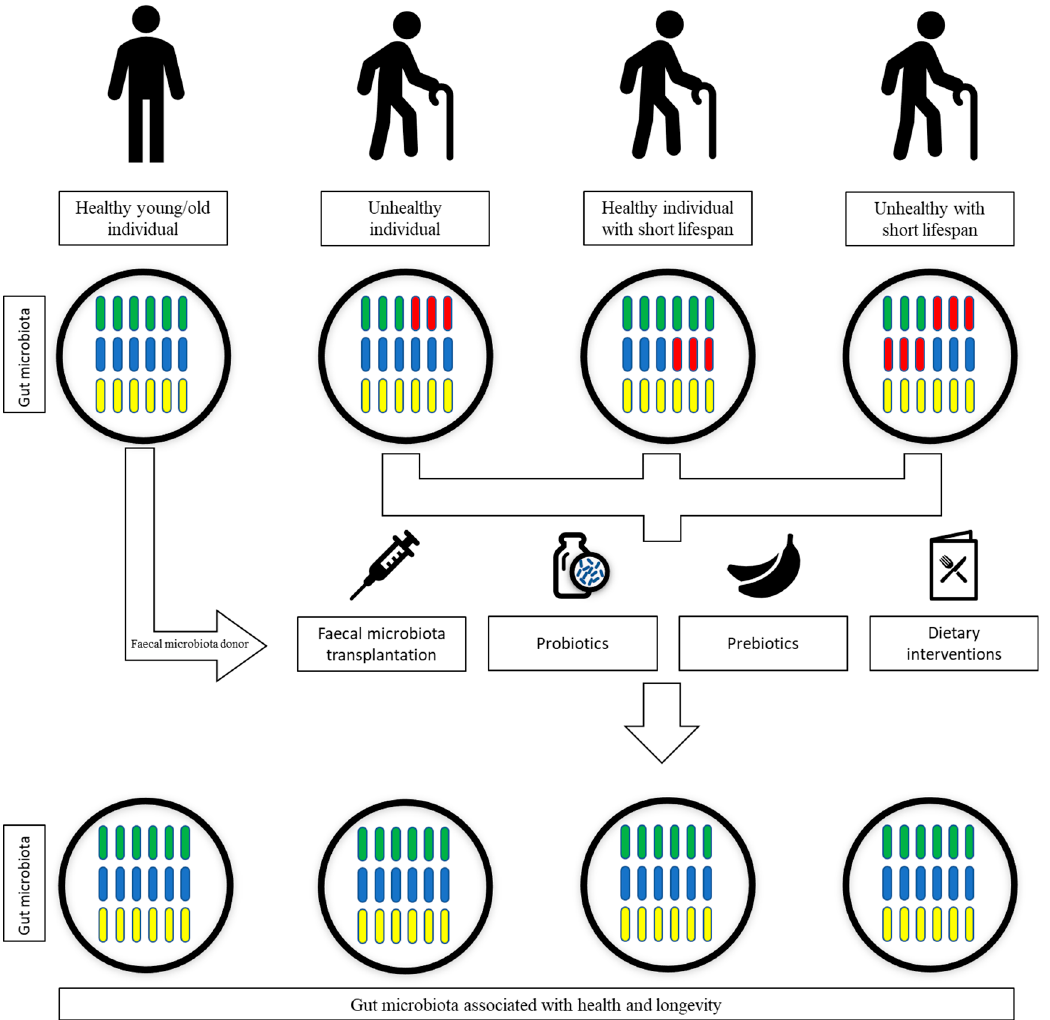
Figure 2. Voluntary modulation of the gut microbiota to improve health and longevity. Gut micro- biota composition and abundance of specific microbes have been linked to health and longevity. Faecal microbiota transplant, prebiotics usage, the use of probiotics and dietary interventions can be exploited to modulate the gut microbiota to have higher abundances of microbes linked with health and